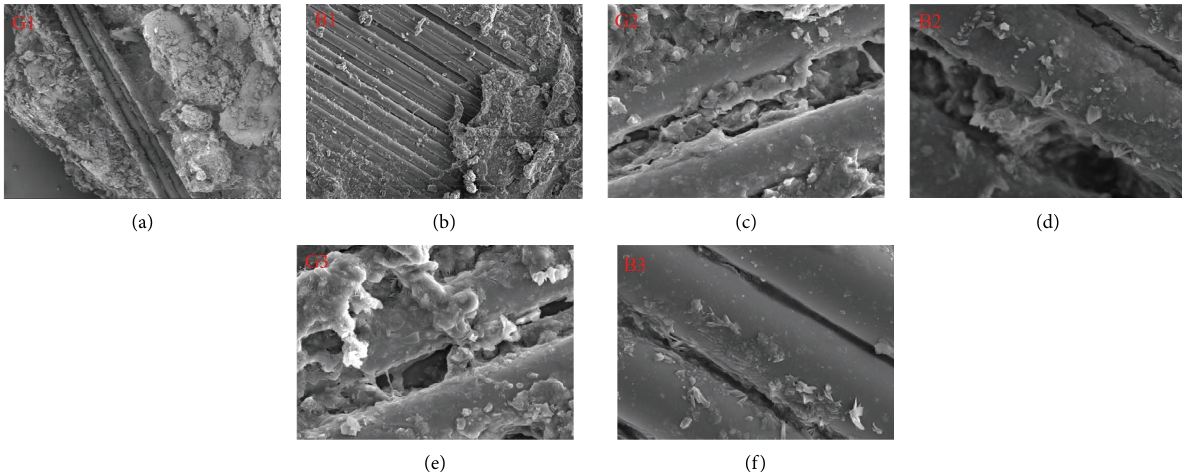
Figure 9: SEM of reinforcement soil of glass fber (a), (c), and (e) and basalt fber (b), (d), and (f).